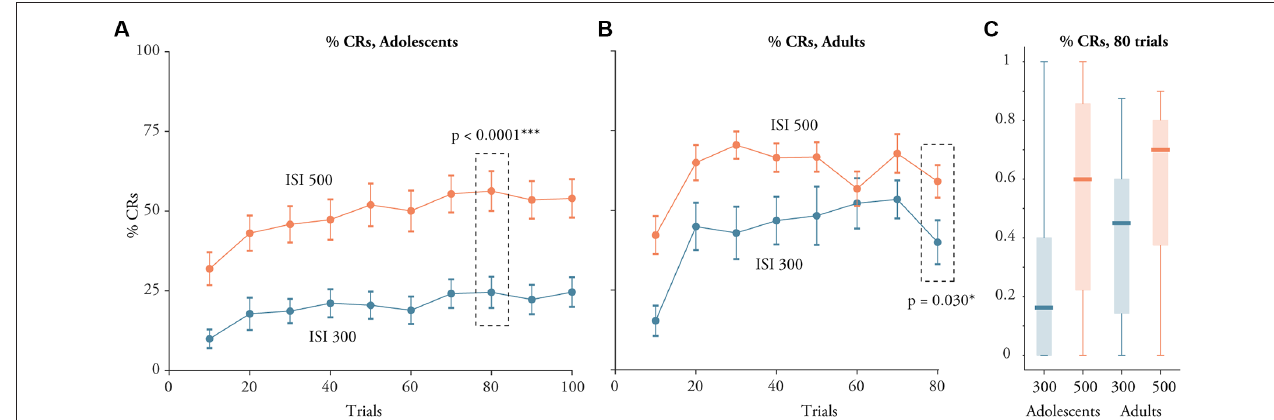
FIGURE 2 | Learning in young adolescents aged 10–15 and adults with a 300 ms or 500 ms ISI. (A) Percent CRs (Mean ± SEM) on 10 successive blocks each consisting of 10 trials among the adolescents. (B) Percent CRs on eight successive blocks each consisting of 10 trials among adults. (C) Boxplots illustrating the distribution of the percentage of CRs in block eight for adolescents and adults. The bottom line represents the minimum value, the lower edge of the box is the first quartile, the line represents the median, the top of the box is the third quartile and the top line is the maximum value.